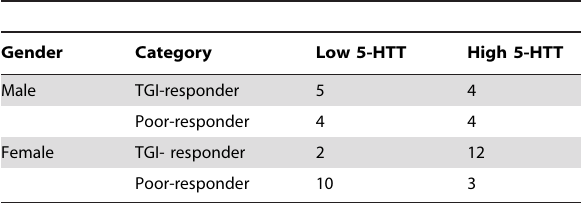
Table 4. Contingency table for perception of the thermal grill illusion